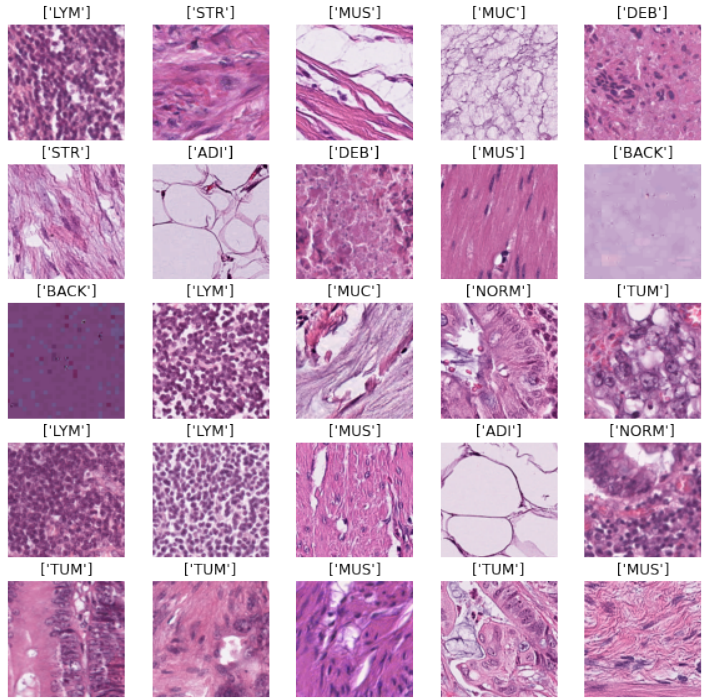
Figure 7. Dataset examples of the different tissues with random augmentation.